Question: Looking at the figure, what chart type is it?
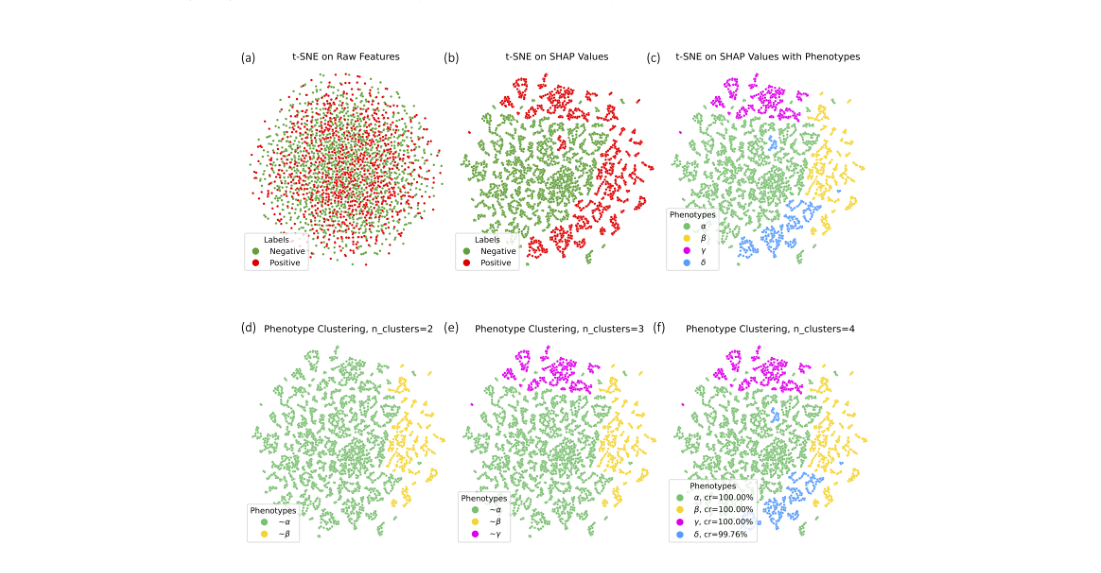
Answer: scatter